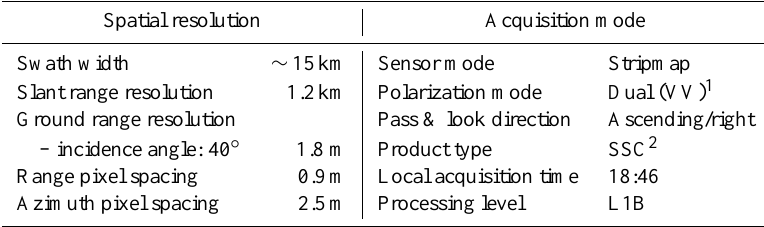
Table 3. Characteristics of the TerraSAR-X sensor and the acquisition mode used for this study (based on CAF,